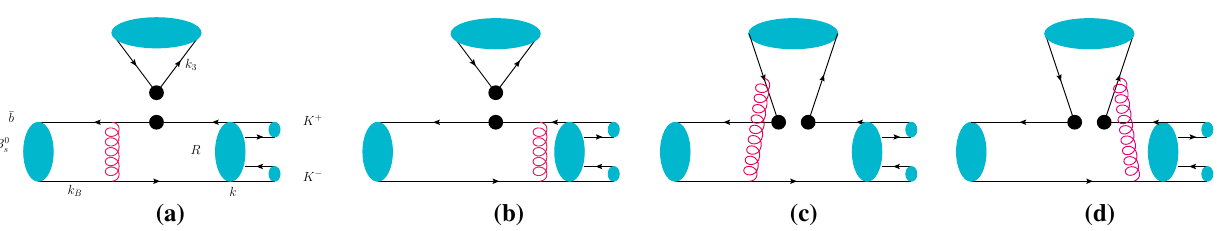
contributed to the nonfactorizable ones. The intermediate R denotes a scalar, vector, or tensor